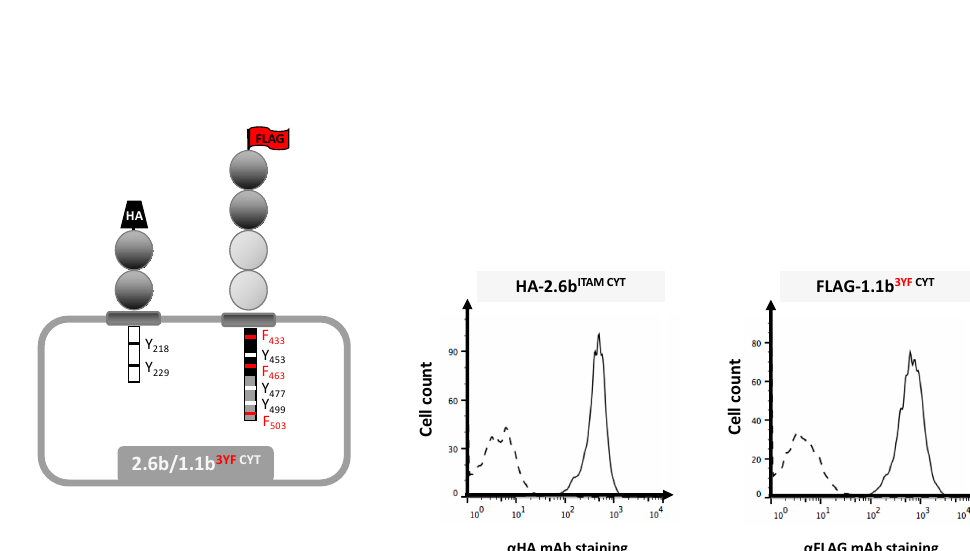
Figure 1. Leukocyte immune-type receptors (IpLITR) co-expressing AD293 cell lines used in this study. Schematic representation of the various N-terminal epitope-tagged IpLITR constructs and their surface expression profiles are displayed for 2.6b ITAM CYT / 1.1b WT CYT ( A ), 2.6b ITAM CYT / 1.1b 6YF CYT ( B ), 2.6b ITAM CYT / 1.1b Prox CYT ( C ), 2.6b ITAM CYT / 1.1b Distal CYT ( D ), and 2.6b ITAM CYT / 1.1b 3YF CYT ( E ). Note: red letters in the schematics indicate a mutant construct with the specific positions of each tyrosine (Y) to phenylanaline (F) mutations shown in red when compared to the non-mutated 1.1b WT construct shown in